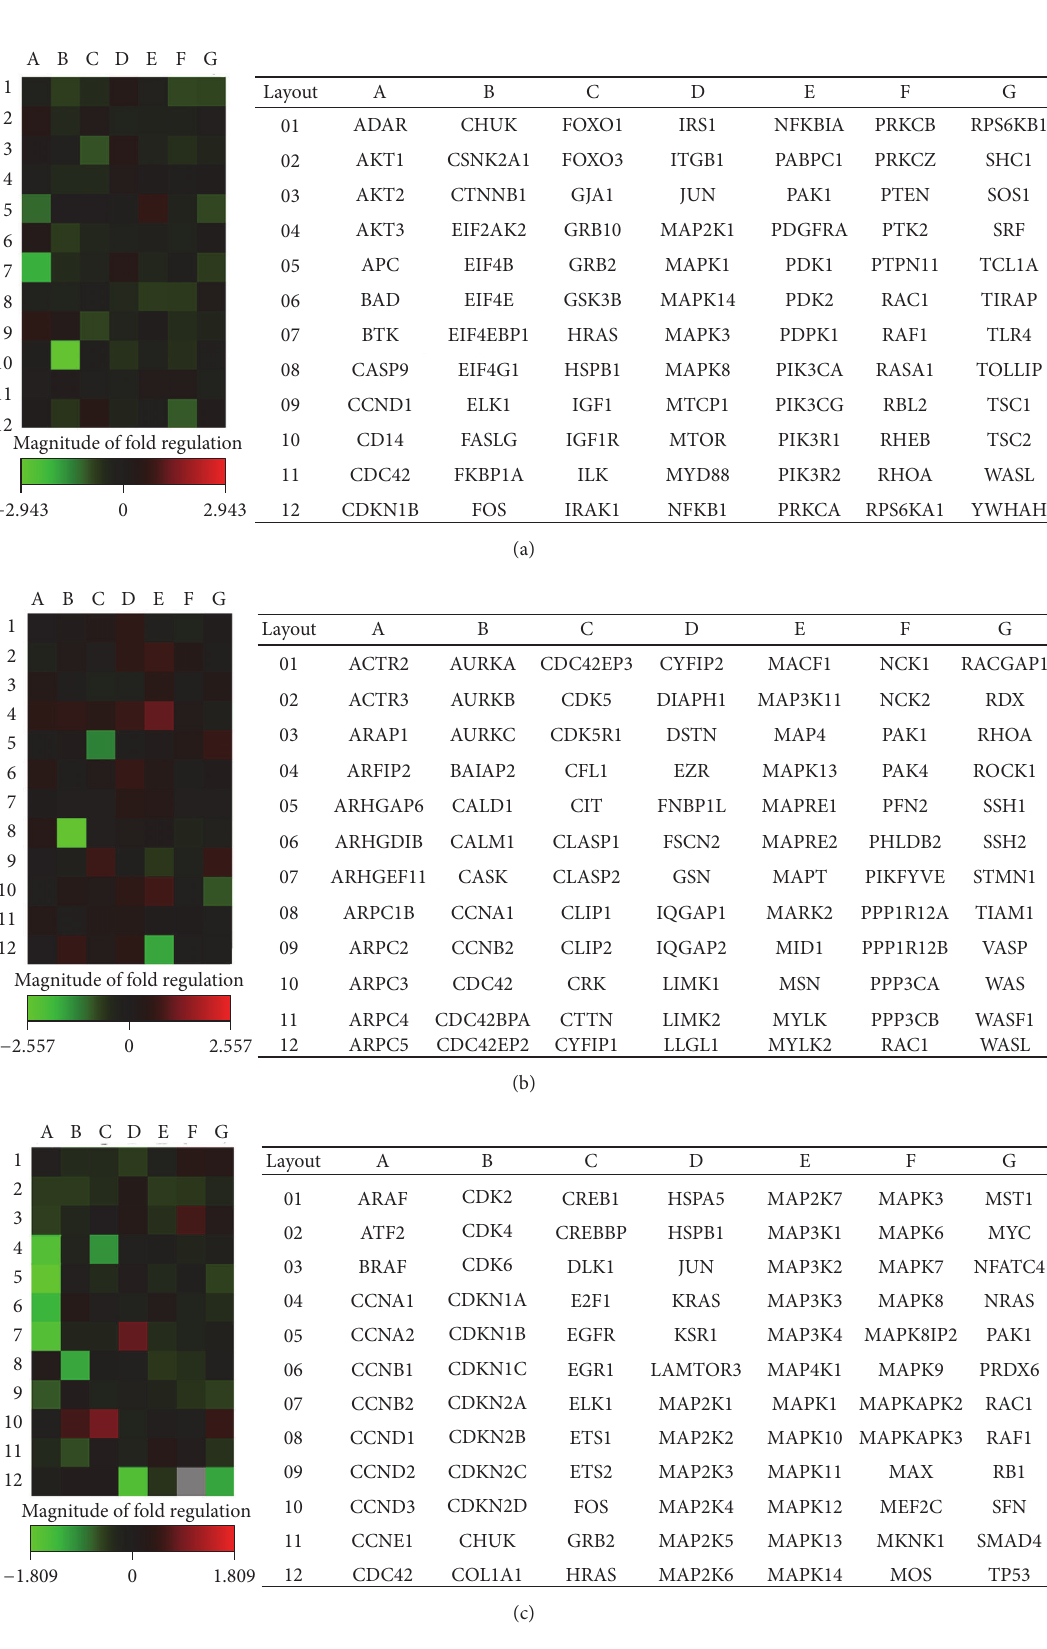
Figure 7: Differential gene expression. Heat maps display the gene expression changes in 84 PI3K-Akt-related (a), cytoskeleton-related (b), or MAPK-related (c) genes in tissue O 2 -adapted adipose tissue-derived mesenchymal stromal cells (ASCs) after short-term hypoxic stress. Gradients indicate the level of gene expression